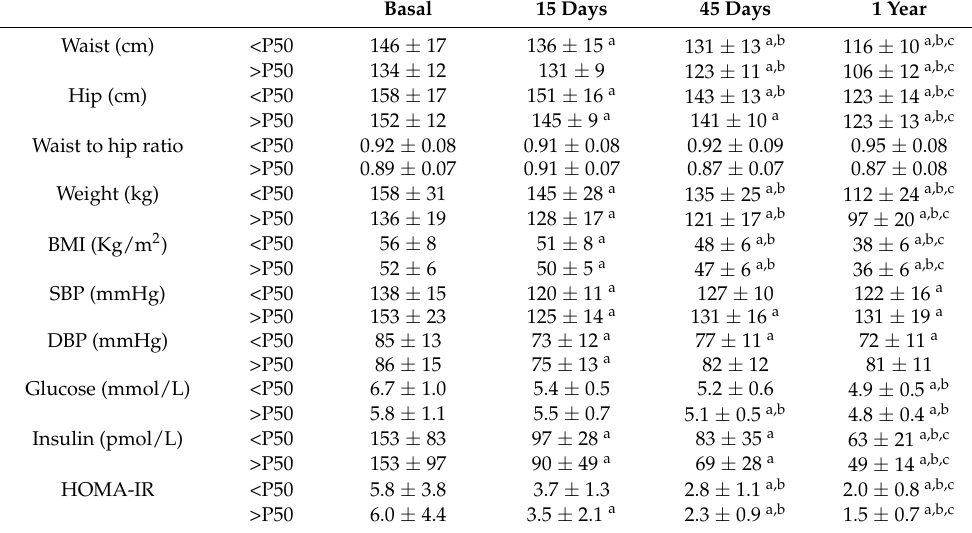
Table 2. Changes in clinical and biochemical variables in patients with class III obesity before bariatric surgery (Basal) and 15 days, 45 days, and 1 year after bariatric surgery according to subcutaneous (SAT) ZAG gene expression levels. Patients were stratified by the 50th percentile of SAT ZAG gene expression